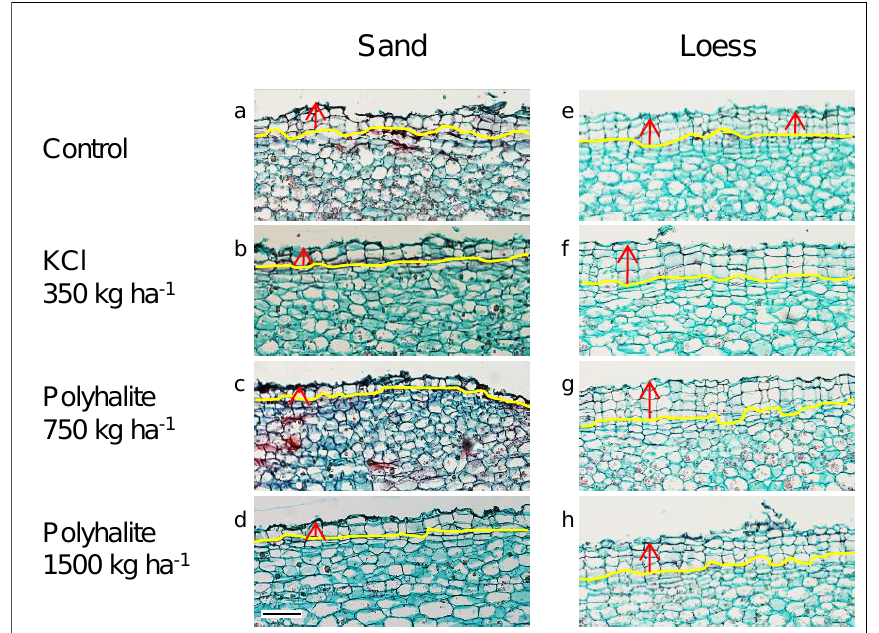
Figure 3. Anatomical study of the skin of sweet potato storage roots (SRs). SRs were collected from plants grown in sandy ( a – d ) and loess ( e – h ) soils, and treated with a preplanting application of the fertilizers KCl at 350 kg ha −1 ( b , f ), or polyhalite at 750 ( c , g ) or 1500 ( d , h ) kg ha −1 . Sections were taken from three independent SRs for each treatment, and one representative section is shown. Tissue morphology was observed under a light microscope. The morphology of the SR skin (located above the yellow line) was characterized by rectangular phellem cells arranged in columns (demonstrated by red arrows). Scale bar = 100 µm.